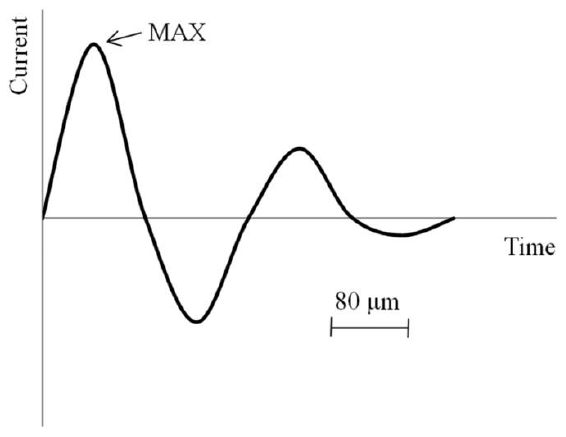
Figure 4. Current oscillogram in electric pulse sintering.